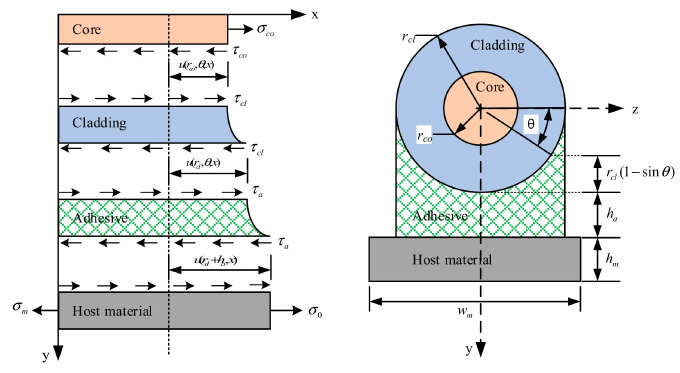
Figure 3. Stress state in four-layer